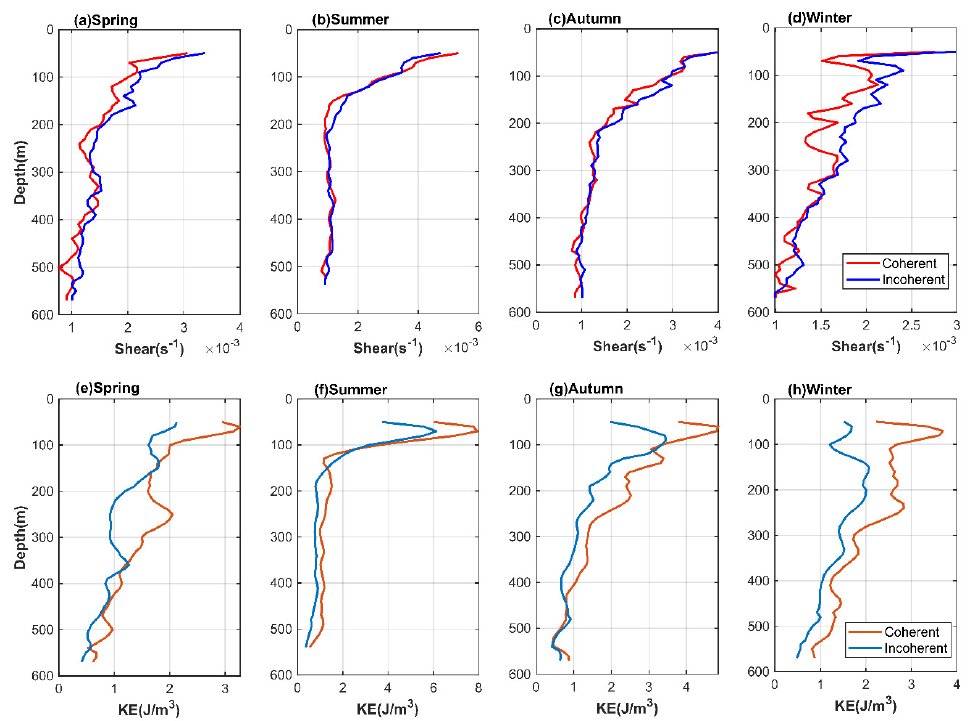
Figure 10. Vertical structures of the seasonal mean shear and kinetic energy densities of the coherent and incoherent components of D1 ITs. ( a – d ) indicate the shear in spring, summer, autumn, and winter, respectively, and ( e – h ) denote the kinetic energy densities in spring, summer, autumn, and winter, respectively.